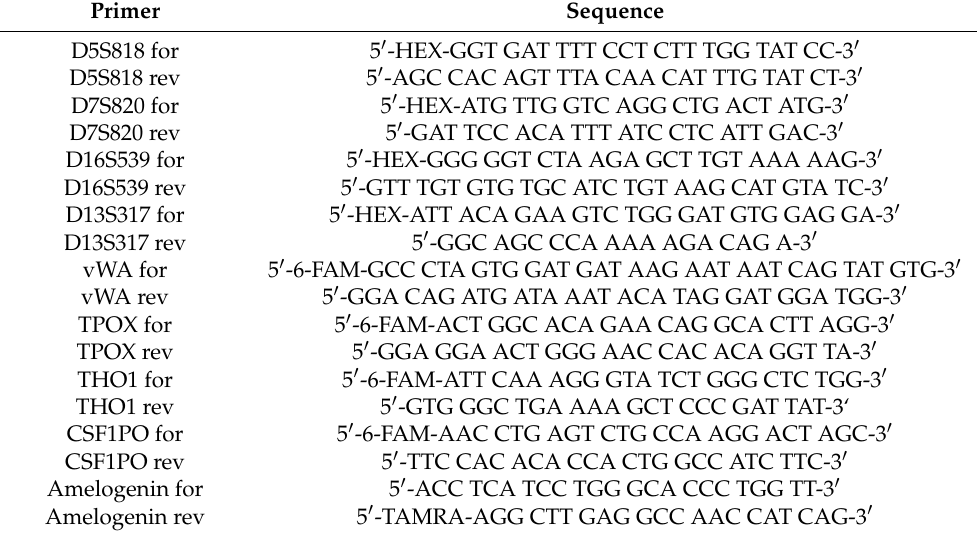
Table 1. Sequences of STR